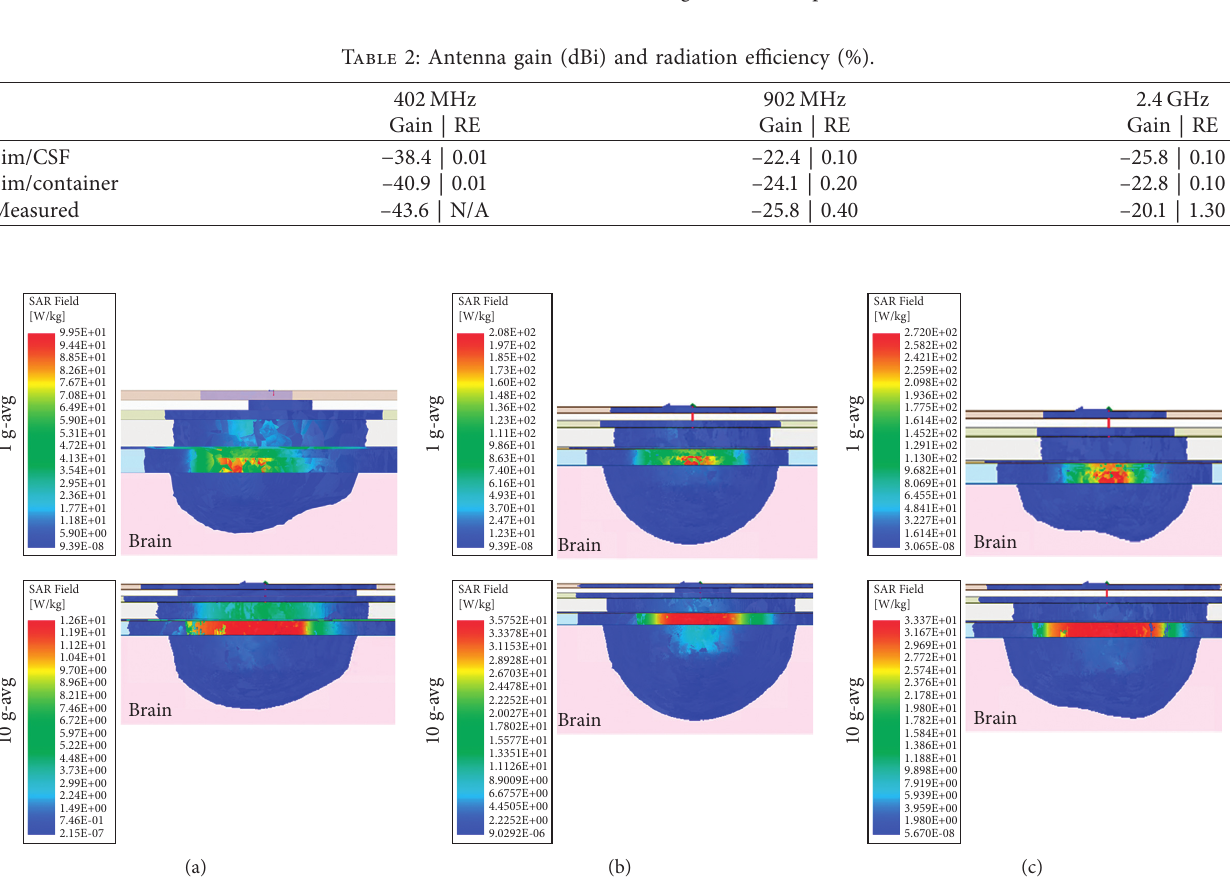
Figure 14: Simulated distribution of 1 g-avg and 10 g-avg SAR for the 7-layer human head model. (a) 402MHz, (b) 902MHz, and (c) 2400MHz. Table 3: Simulated maximum average SAR values for 1 W input power and maximum allowable input